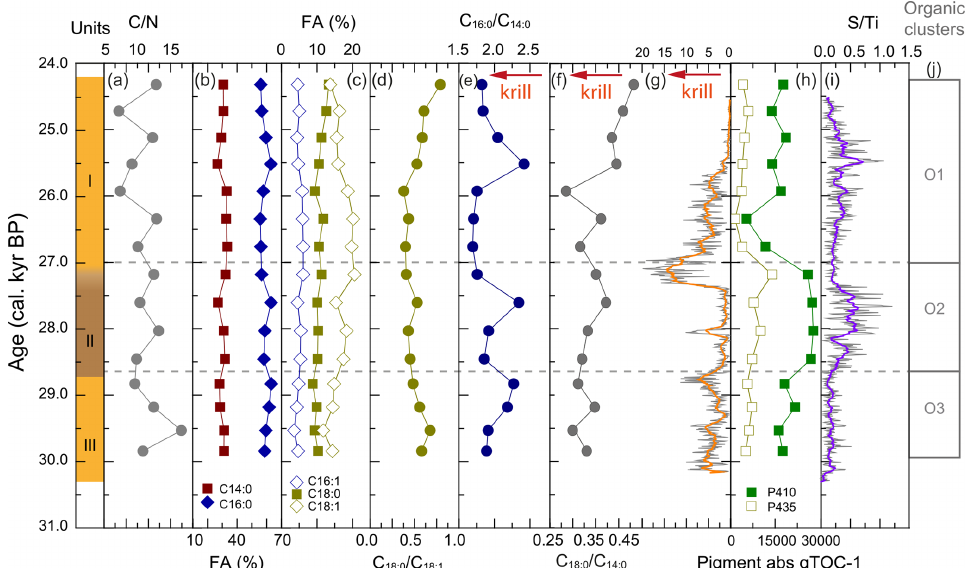
Figure 4. Organic matter composition of stomach-oil deposit WMM7. The age model uses Holocene “no sea ice” (cid:49)R (Table 1). Unit II is highlighted with brown shading, noting the gradual Unit II–I boundary. Cluster boundaries are determined by constrained hierarchical clustering analysis in the rioja package of R (Juggins, 2020) compared to a broken-stick analysis (Bennett, 1996). Three significant clusters were identified (j) , which broadly coincide with Units I–III, noting the gradual Unit II–I boundary. The Cu / Ti data from Fig. 3 are shown in (g) , noting the reverse x axis to align with the interpretation fatty acid indicators of krill in (e) and (f) .